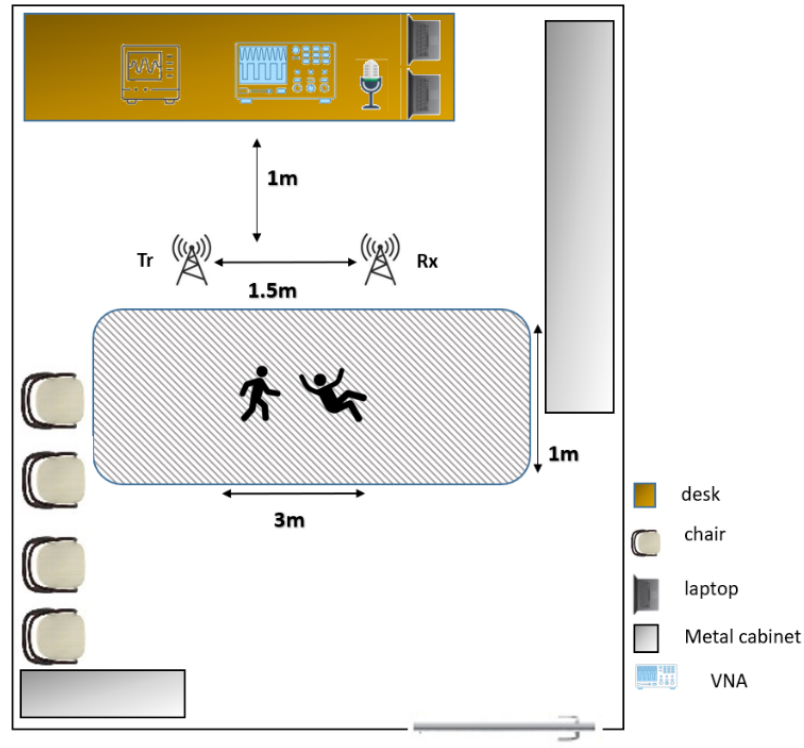
Figure 9. Schematic of the new room data recording setup. Walking and falling activities were performed in the dashed area without blocking the line-of-sight path between Tr and Rx. The walking activity was performed without any pattern, similar to the walking activity in the random set. The falling was performed in different directions in the dashed area. Measurement device placements in this room were different from that of the lab environment.